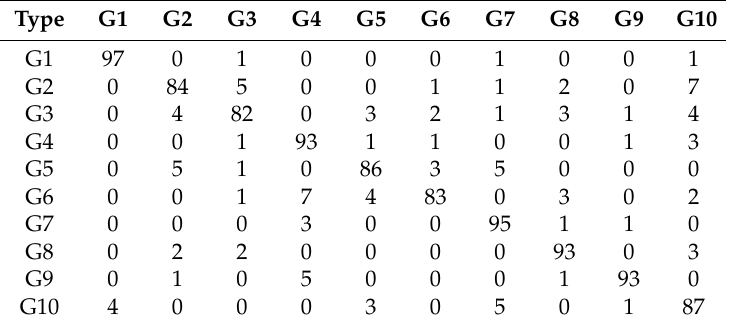
Table 3. Recognition rate with Euclidean